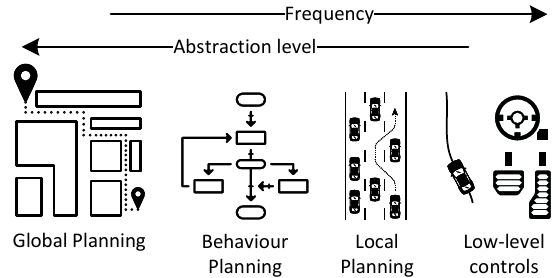
Figure 1. Hierarchical vehicle control